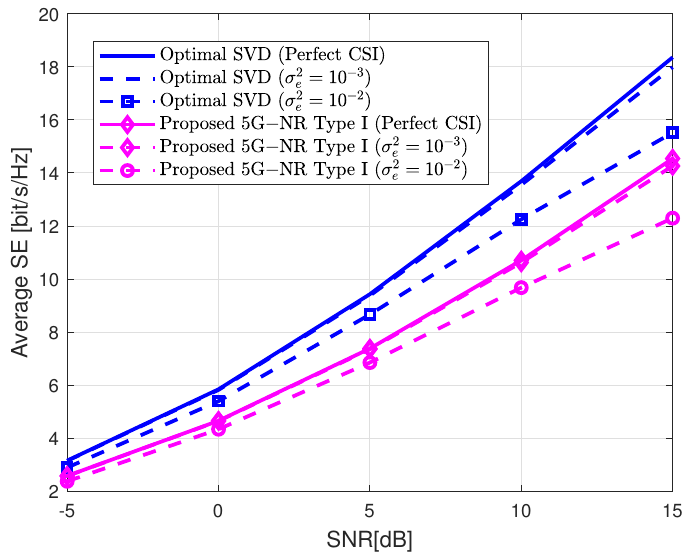
Figure 7. Average SE vs. SNR for SU-MIMO systems assuming 𝑁 𝑡 = 8, 𝑁 𝑟 = 4, and 𝑁 𝑠 = 3. The gNB is implemented assuming a single-panel ULA with four DP polarized antenna elements in the horizontal dimension ( 𝑁 1 = 4 and 𝑁 2 =